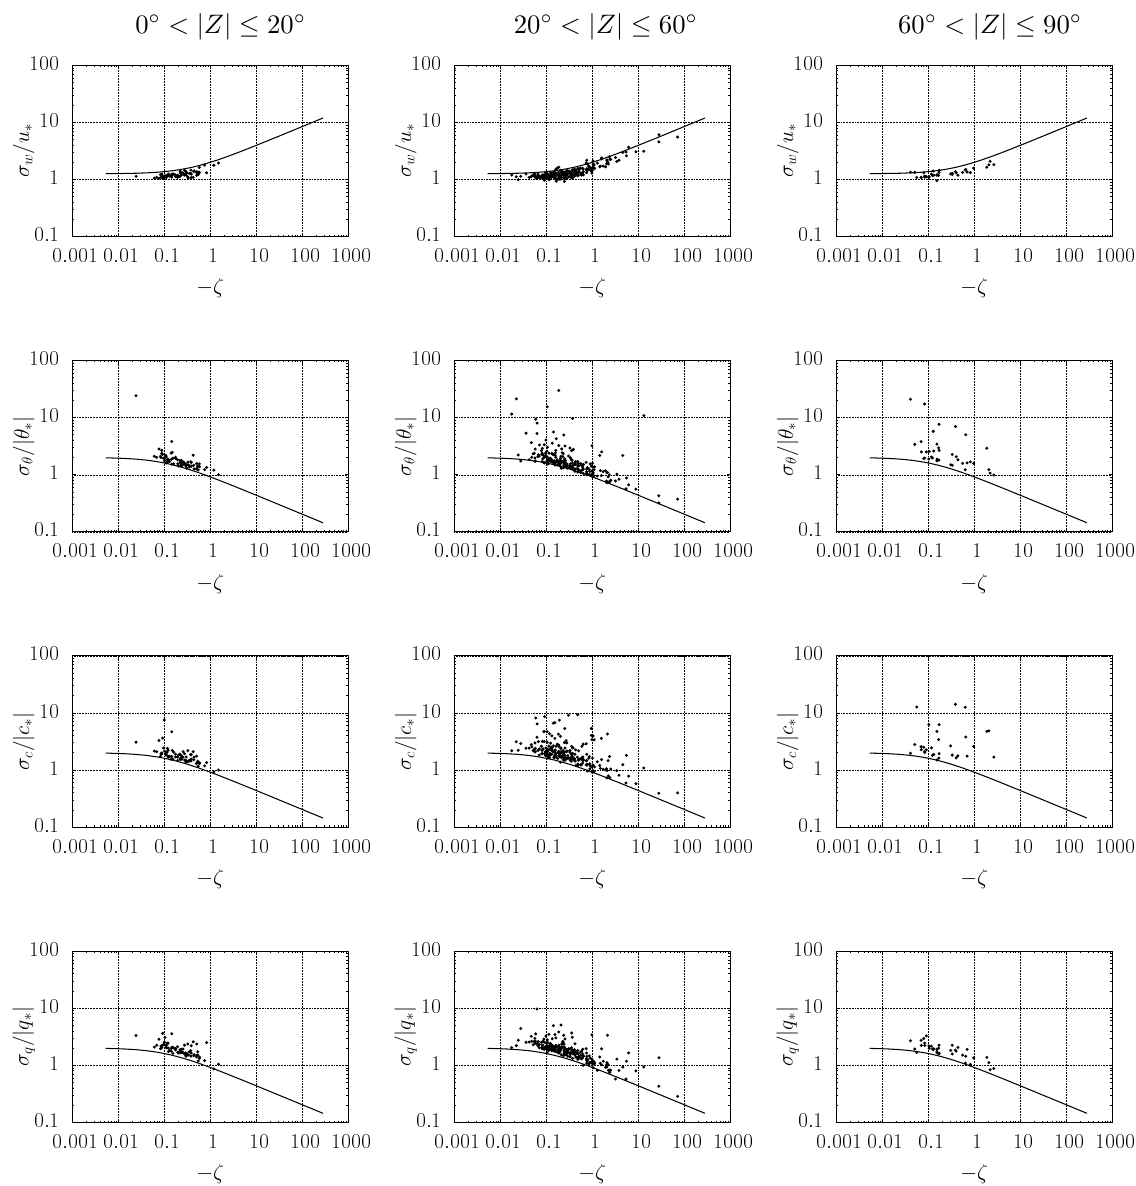
Figure 6. Dimensionless standard deviation with solar angle: 39.4m. First row shows the velocity similarity function, the second shows temperature function, and the third and fourth show CO 2 and water vapor,